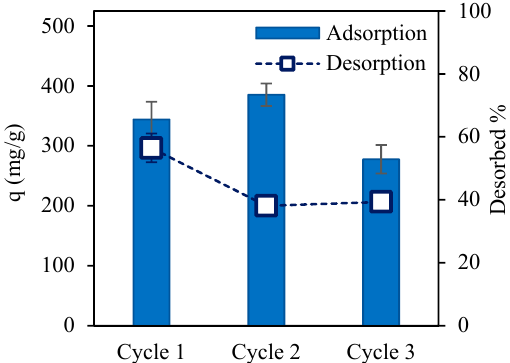
Figure 6. Results obtained in the adsorption ( C 0 = 500 mg L − 1 , S/L = 1.0 g L − 1 , 20 °C) and desorption cycles (eluent: 0.5 mol L − 1 thiourea and 0.5 mol L − 1 HCl solution, S/L = 2.5 g L − 1 , 20 °C).